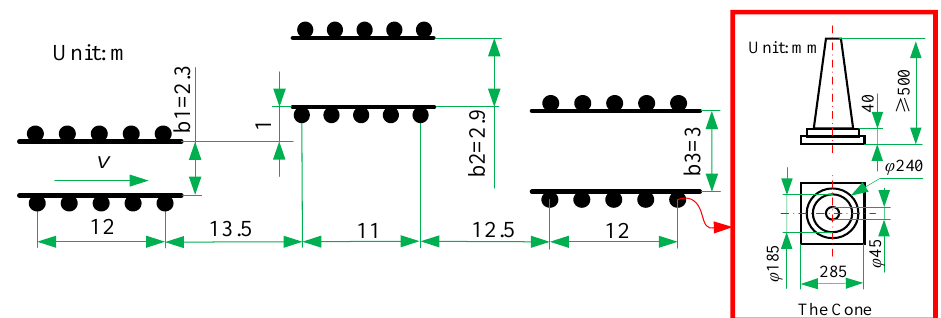
Figure 4. Schematic diagram of the location of the double shift line test pile.